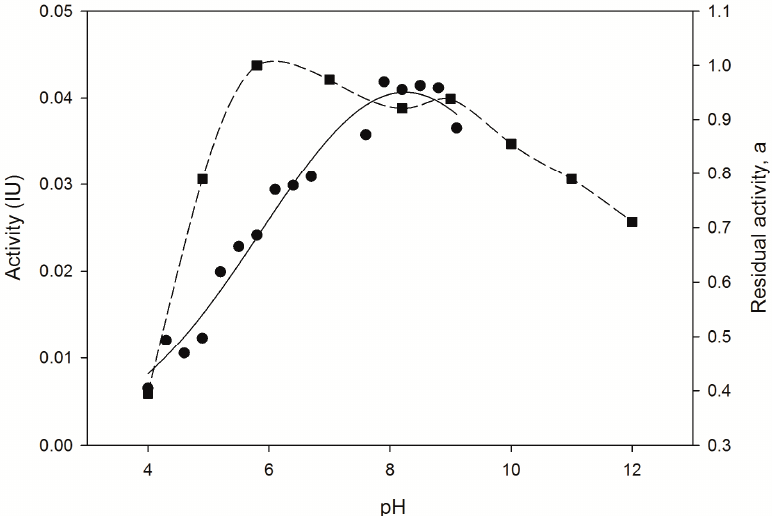
Figure 2. pH dependence of Bp NDT activity. Effect of pH on the Bp NDT activity (  ) and stability (  ) 0.4 µg of enzyme were incubated with 40 µL of 10 mM dUrd and Thy in 10 mM citrate-phosphate buffer for 5 min, 40 °C. The ionic strength (I) at each pH was adjusted to 150 mM by addition of NaCl.